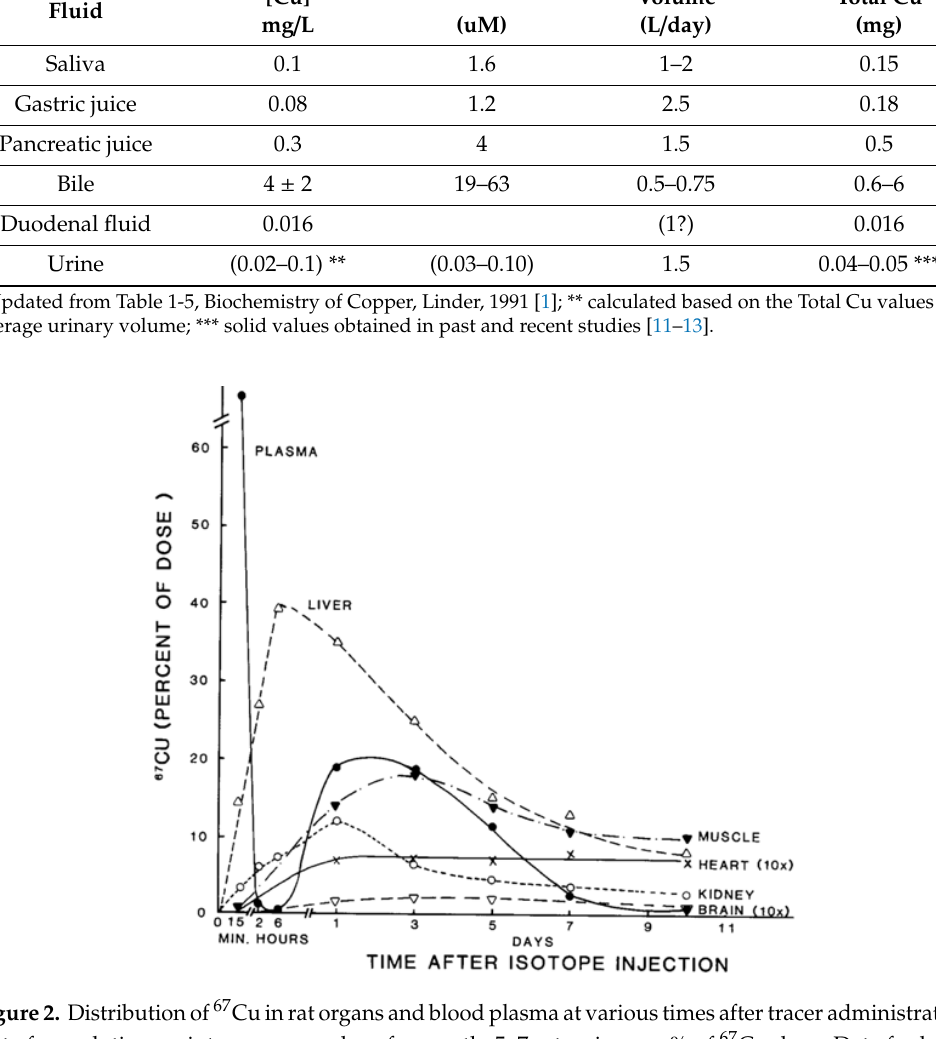
Figure 2. Distribution of 67 Cu in rat organs and blood plasma at various times after tracer administration. Data for each time point are mean values for mostly 5–7 rats, given as % of 67 Cu dose. Data for brain and heart have been multiplied 10× to make them more visible. Reprinted with permission from reference Weiss, K.C.; et.al.